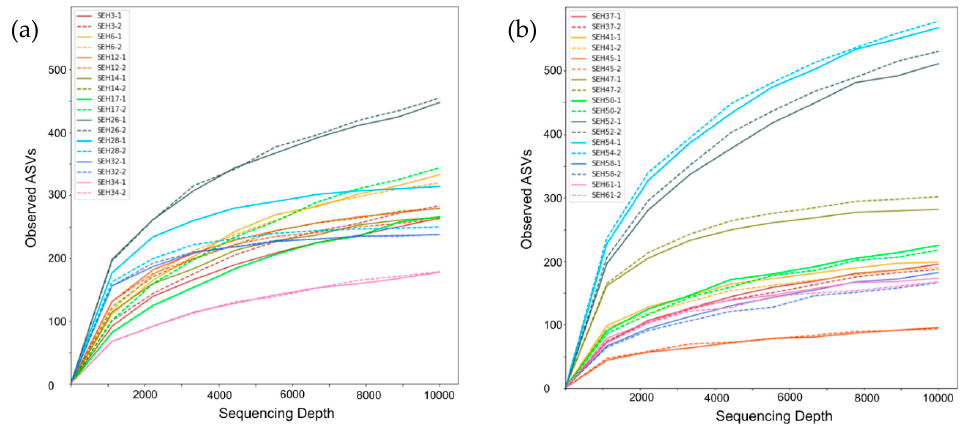
Figure 1. Rarefaction curves of all samples. ( a ) Rarefaction curves for SEH3 to SEH34 and ( b ) rarefaction curves for SEH37 to SEH61. Dotted lines are the duplicates of solid line samples in various colors.